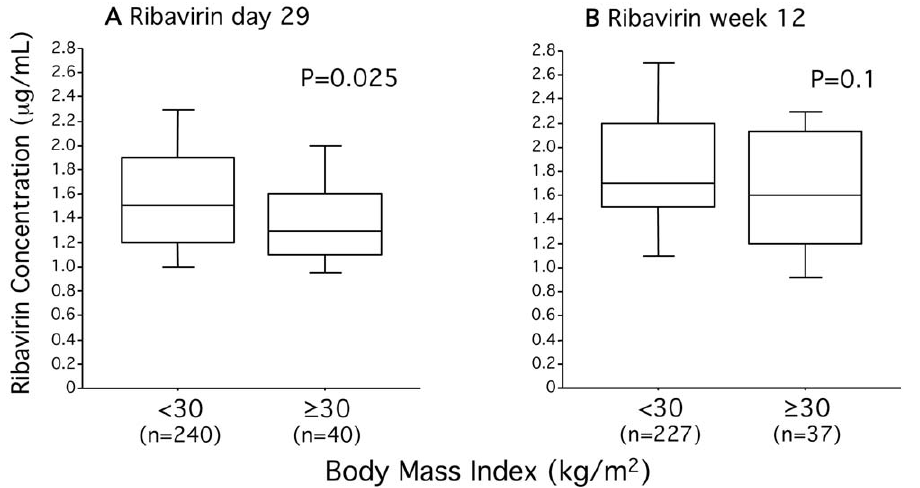
Figure 3. Impact of obesity on ribavirin concentrations. Box plots displaying the 10 th , 25 th , 50 th , 75 th , and 90 th percentiles of the plasma concentrations of ribavirin ( m g/mL) treatment day 29 and week 12 ( A and B respectively). P-values obtained using Mann-Whitney U-test.